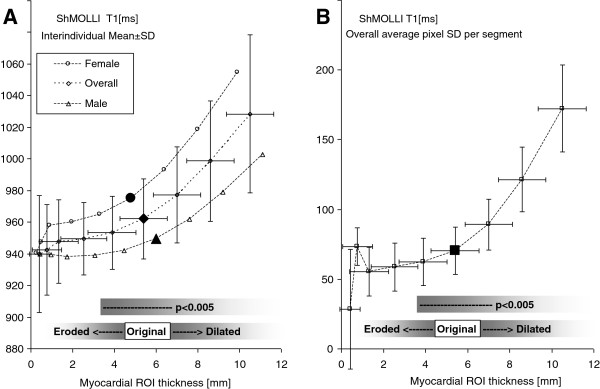
The effect of partial volume on A) average myocardial T1 and B) average segmental pixel variability. Notes: Myocardial ROI thickness is calculated as distance between endo- and epi-cardial contours. Filled large symbols represent the T1 derived from myocardial contours drawn manually by the operator (original) compared to systematic erosion or dilatation in 1-pixel increments. P values refer to comparisons between subsequent inflation/erosion steps.